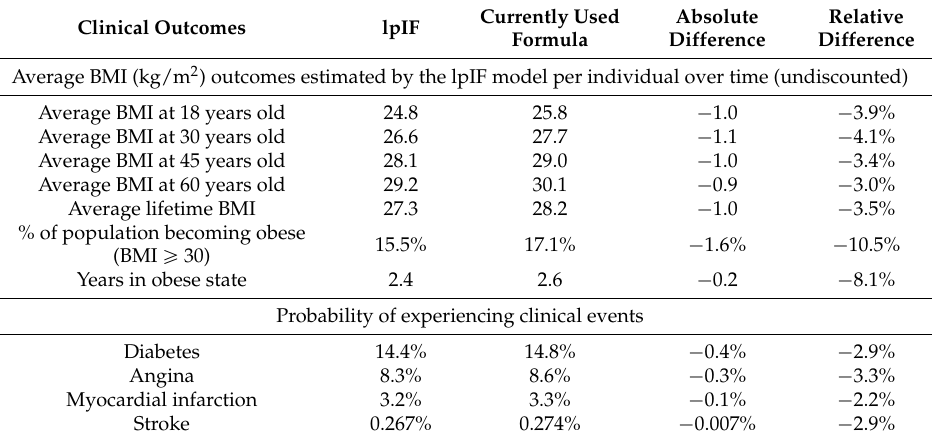
Table 3. Base-case clinical outcomes.